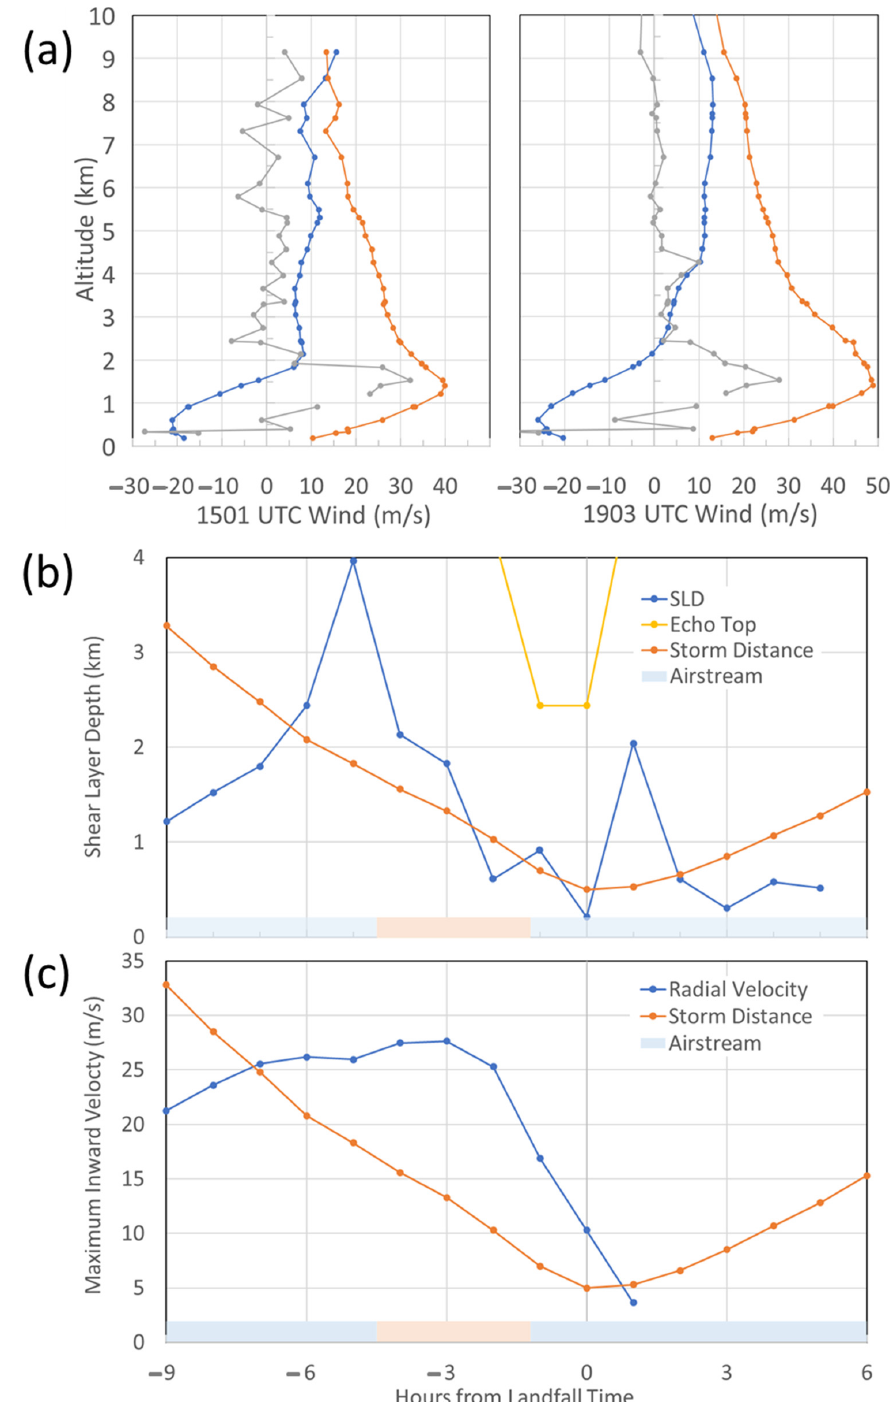
Figure 11. Vertical wind profiles observed at Fort Dix, NJ, by the Doppler radar using its velocity azimuth display (VAD) algorithm. ( a ) Vertical profiles of radial (blue) and tangential (red) wind components relative to the moving storm center and of the vertical shear of the radial wind component (gray). Units of the latter are 0.001/s. ( b ) Time series of hourly observations of radial wind shear layer depth (blue), top of radar echoes (yellow), and distance of storm center from radar site (red) with units in km/100. Horizontal colored bands above time scale denote when the radar site was within CCB (blue) and WCB (pink) airstreams. ( c ) Similar to ( b ) except that blue represents maximum inward radial velocity and storm distance units are km/10.